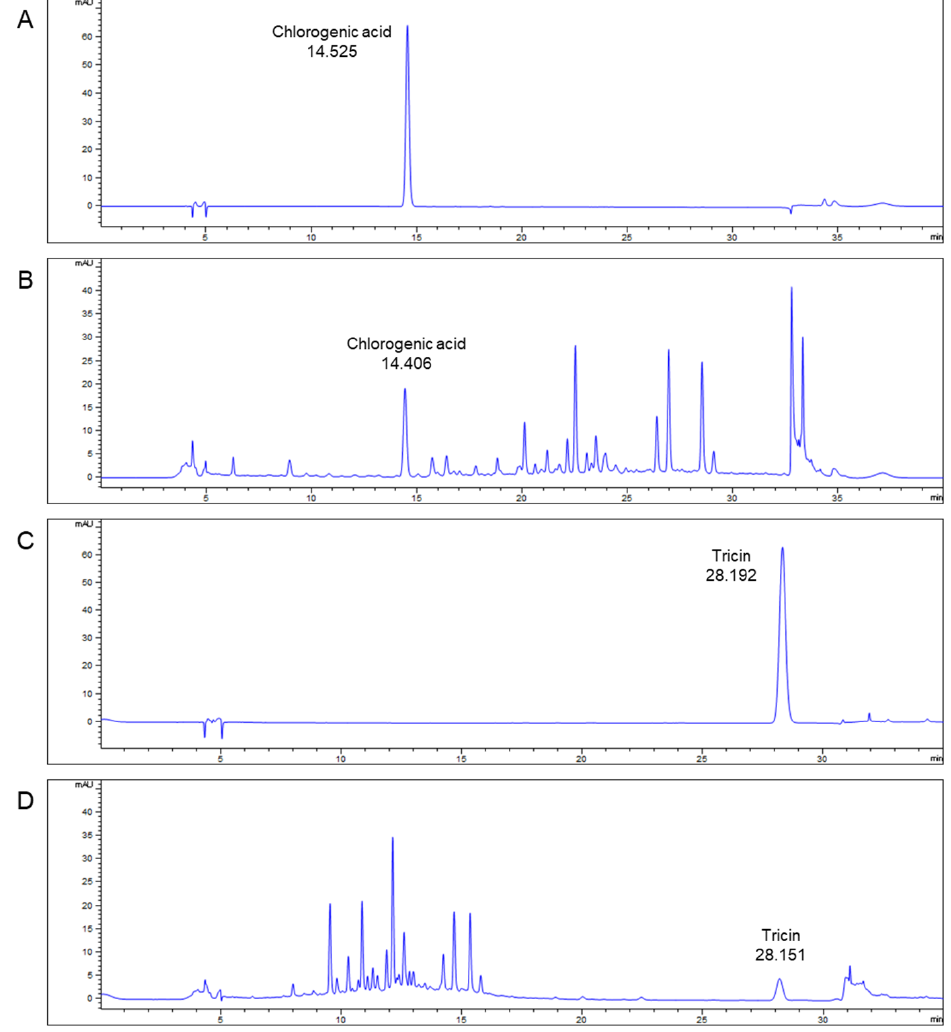
Figure 2. Qualitative analysis of TEES-10 ® via High Performance Liquid Chromatography. ( A ) and ( B ) were produced under the same mobile phase condition for analysis of chlorogenic acid. ( C ) and ( D ) were produced under the same mobile phase condition for analysis of tricin. The retention times of the standard chlorogenic acid and tricin were 14.525 and 28.192 min, respectively. The retention times of chlorogenic acid and tricin in TEES-10 ® were 14.406 and 28.151 min, respectively.